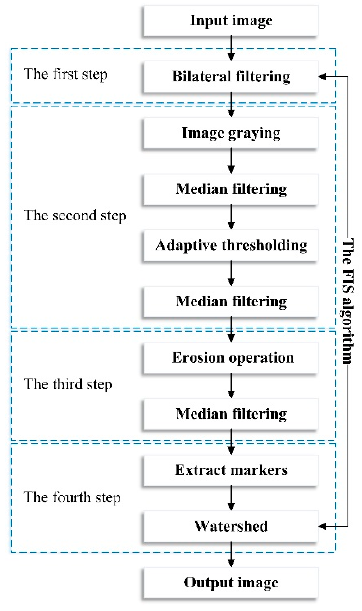
Figure 7. Block diagram of the fine image segmentation (FIS) algorithm.